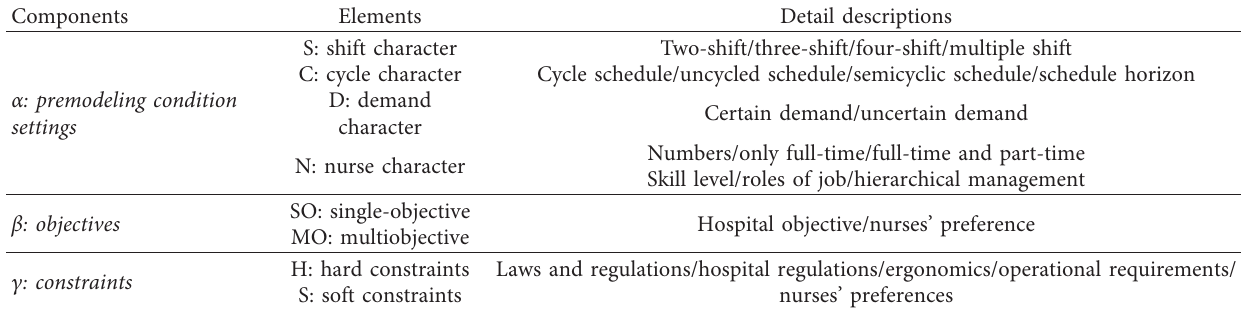
Table 1: Construction of model for nurse rostering